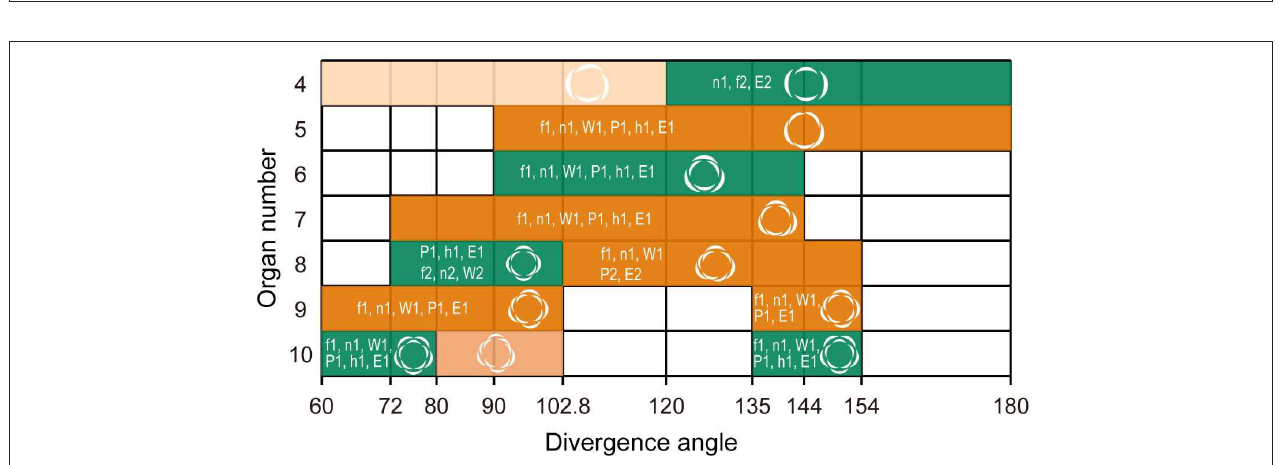
FIGURE 2 | consistently with coloring in Supplementary Table 1 . 10-tepaled aestivation in orange denotes EAIEAIEIEI. The other aestivations with relative frequency below 10% are shown in black. Representative images of the major aestivations are shown for each species and form at the right side of the floral diagrams. N/A indicates the sample size was below 30. The rank in each tepal number indicated a negative correlation between tetramerous and trimerous double-whorls; trimerous and tetramerous double-whorls ranked first for 6-tepaled and second for 8-tepaled flowers, respectively, for A. flaccida, A. nikoensis, and A . × hybrida W; these ranks were the opposite for A. × hybrida PP and E. pinnatifida .